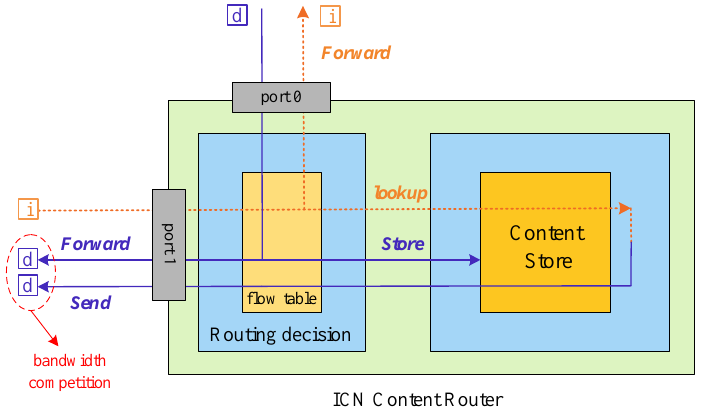
Figure 1. Information-centric network (ICN) router with content store.